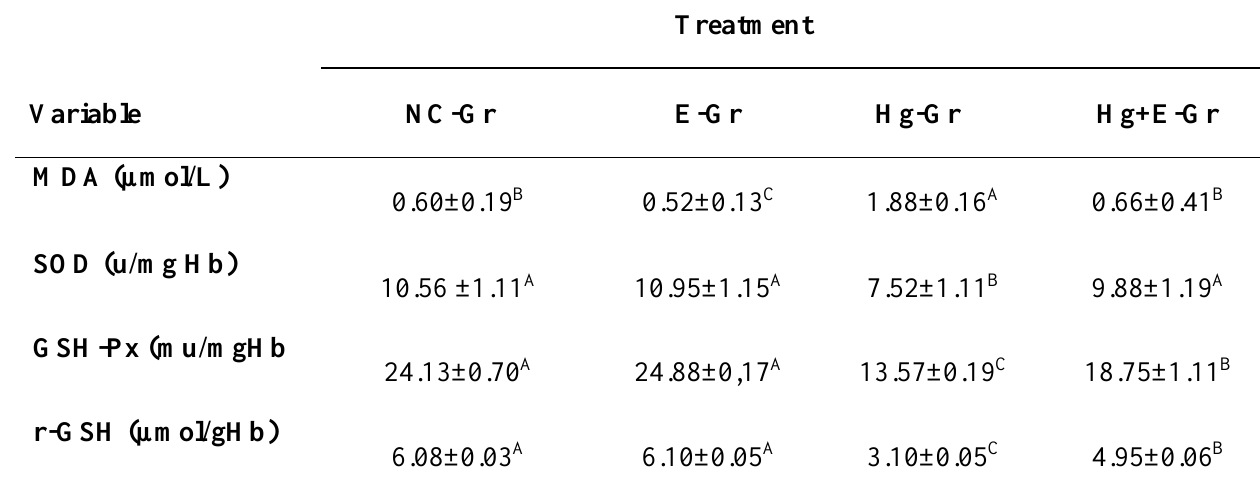
Table 2. The protective role of Vitamin E against the toxic effects of mercuric chloride on the serum levels of each of malondialdehyde (MDA), reduce form glutathione (r-GSH), superoxide dismutase (SOD) and glutathione peroxidase (GSH-Px) on day 43